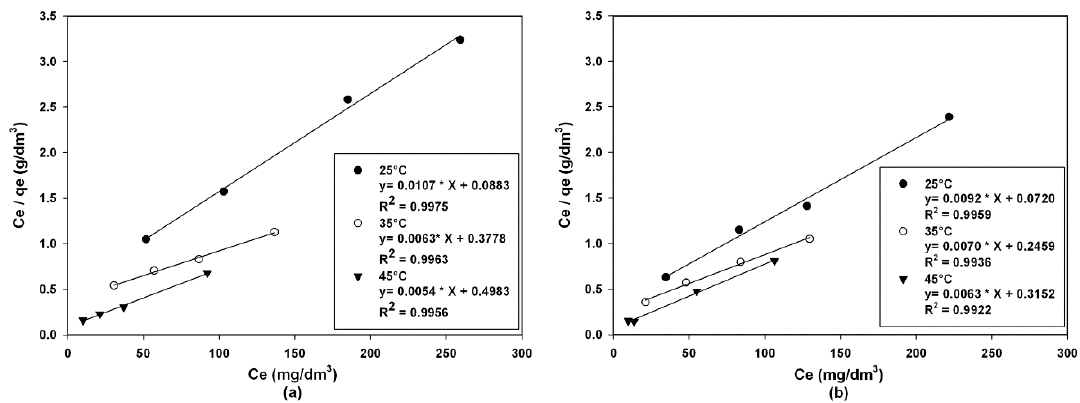
Figure 6. Freundlich isotherm of gold adsorbed onto (a) ARH and (b) L-214 (30 mg sorbent, 60 min, 100 rpm, pH=6.1, 10 mL sol. at a concentration of 200–500